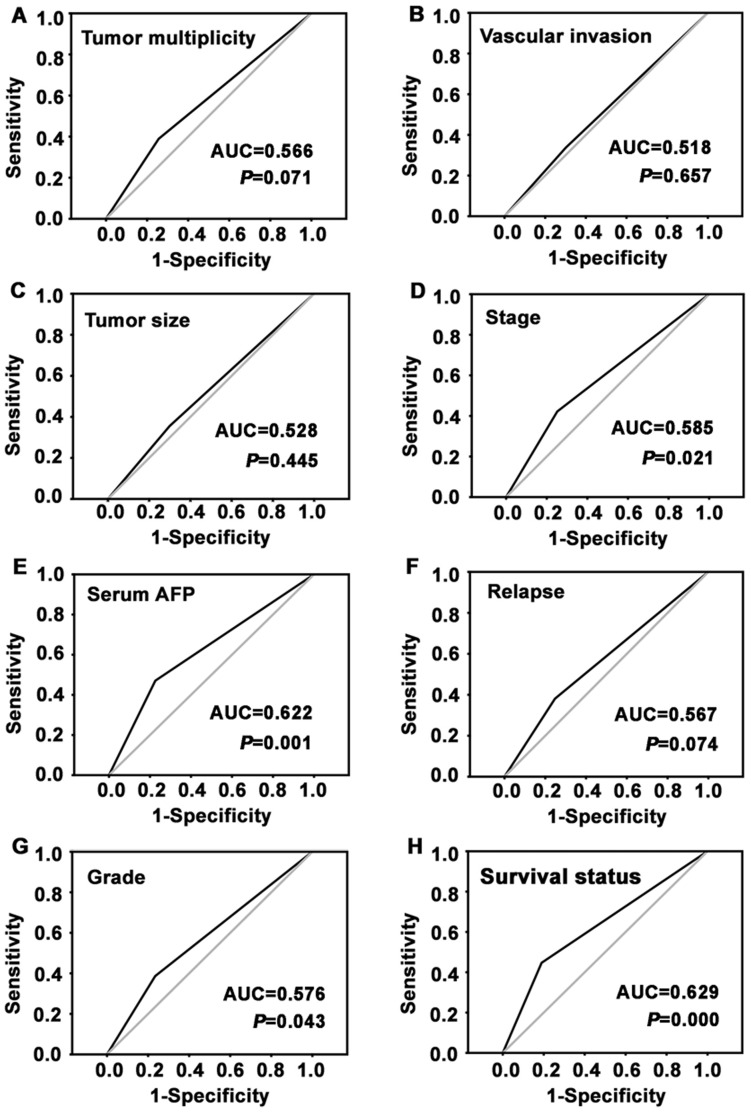
Determination the cutoff value of low SIRT3 expression in primary HCC tissues by receiver operating characteristic (ROC) curves.For each parameter of HCC patients, including tumor multiplicity, tumor size, serum AFP, pathological grade, clinical stage, vascular invasion, relapse and survival status, the sensitivity and 1-specificity were plotted. The areas under curve (AUC) and the P value were indicated.